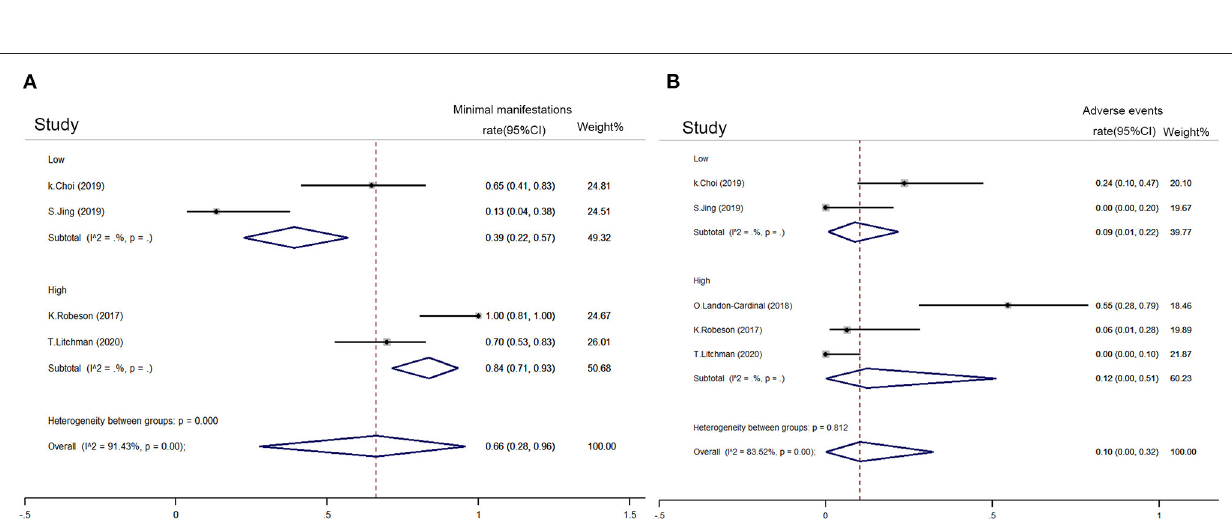
Frontiers in Neurology |